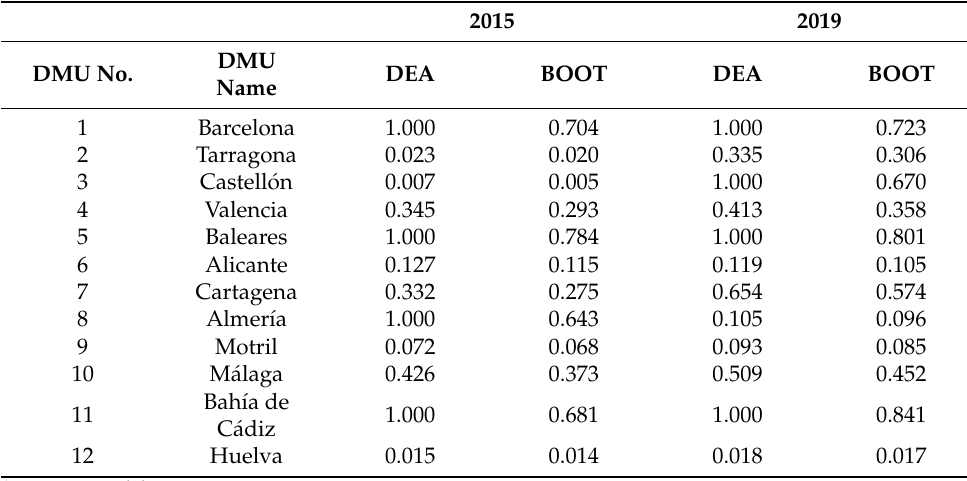
Table 3. DEA and DEA-BOOT results for